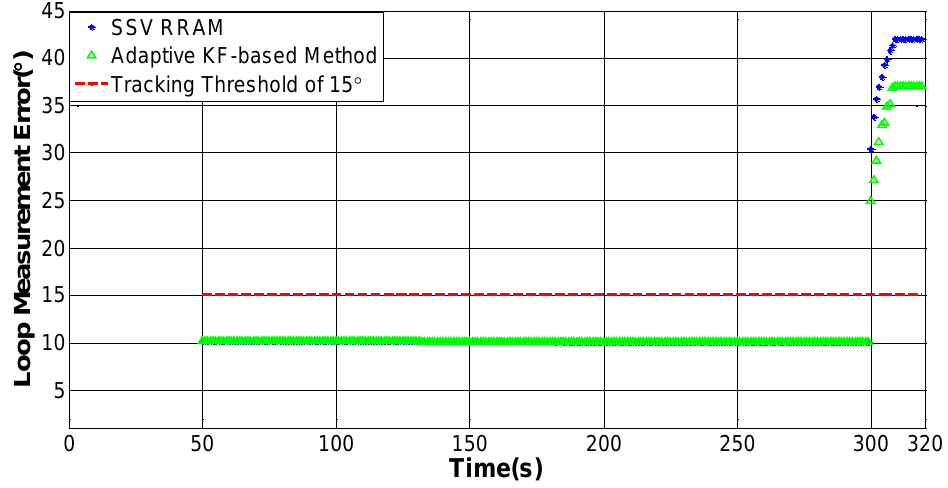
Figure 8. PLL lock status of two CL form tracking strategies, SSV RRAM and the adaptive KF-based method.